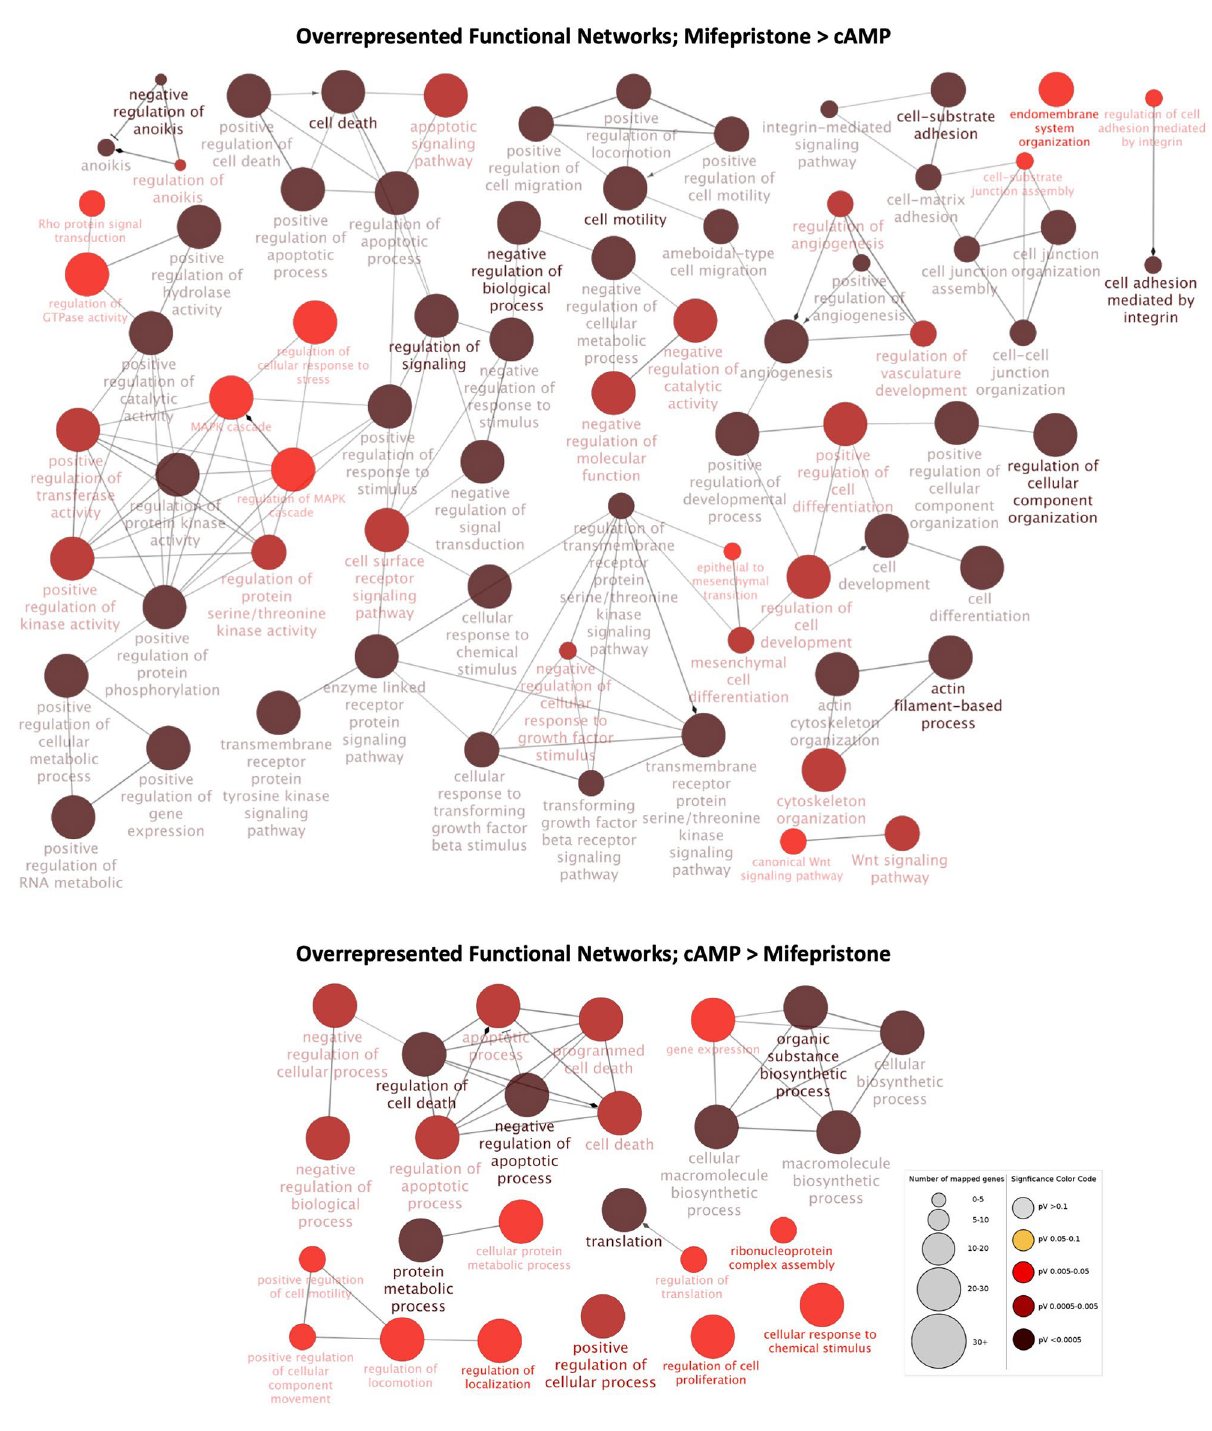
Figure 5. Functional networks overrepresented in the contrast “mifepristone versus cAMP” as determined by ClueGO (Cytoscape). Redundant and non-informative terms were removed, and the resulting networks were manually rearranged. The number of mapped genes for each term is represented by the node size, whereas the level of enhancement is denoted by node color (presented in the figure legend). The overrepresented functional networks for the DEGs upregulated in decidualized DUS cells by treatment with mifepristone (upper diagram) were mainly related to the apoptotic process, anoikis and Wnt signaling, cell motility and adhesion, epithelial mesenchymal transition, response to growth factors, protein kinase activity and angiogenesis. Networks overrepresented in the DEGs downregulated by mifepristone (lower diagram) were, similar to upregulated DEG, associated with cell death and mobility, while also being related to translation and cellular